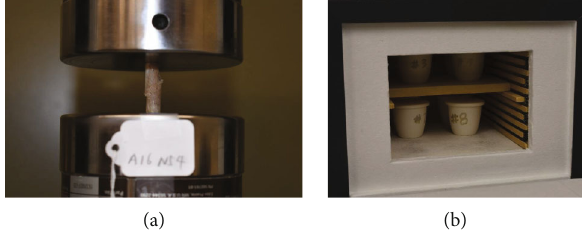
Figure 2: (a) Compression testing. (b) Bone ashing. Table 1: Spearman correlation ( p value) between organic-inorganic phase ratio and bone material